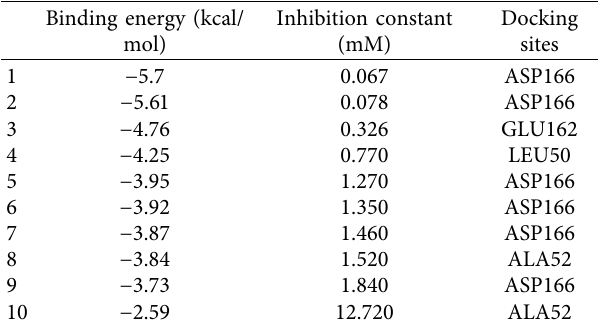
Table 1: Docking result